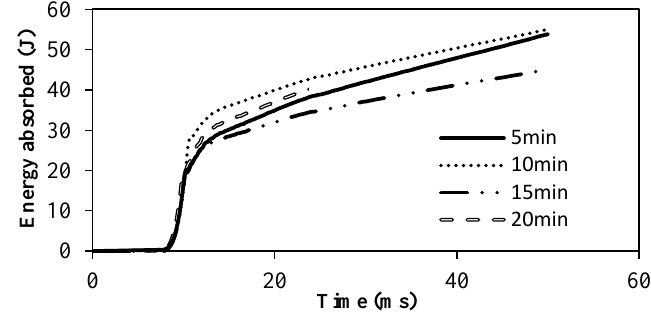
Figure 10. Impact test at constant curing temperature (170 °C).